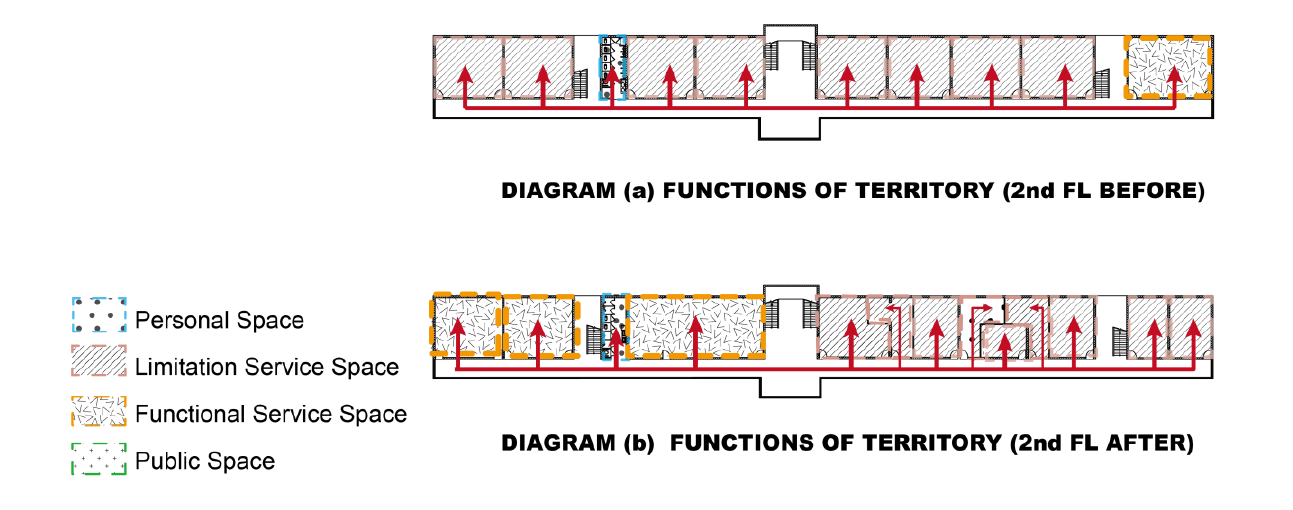
Figure 16. Pingtung AI Agri Hub Territory Order Diagram: First Floor Plans. ( a ) Second Floor Plans Before Redesign. ( b ) Second Floor Plans After Redesign.